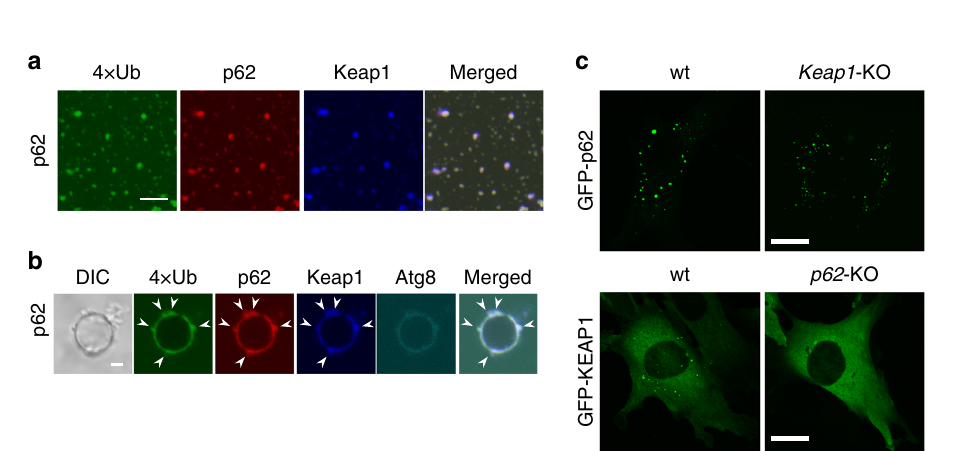
(Fig. 6c). Immunoprecipitation assay with Keap1 antibody showed that both p62 and S349-phosphorylated p62 were co- immunoprecipitated with Keap1, and both interactions decreased by the treatment of KMN003 in a dose-dependent manner (Fig. 6d). Treatment of Huh-1 cells with KMN003 increased the level of endogenous Keap1 (Fig. 6d), suggesting impairment of